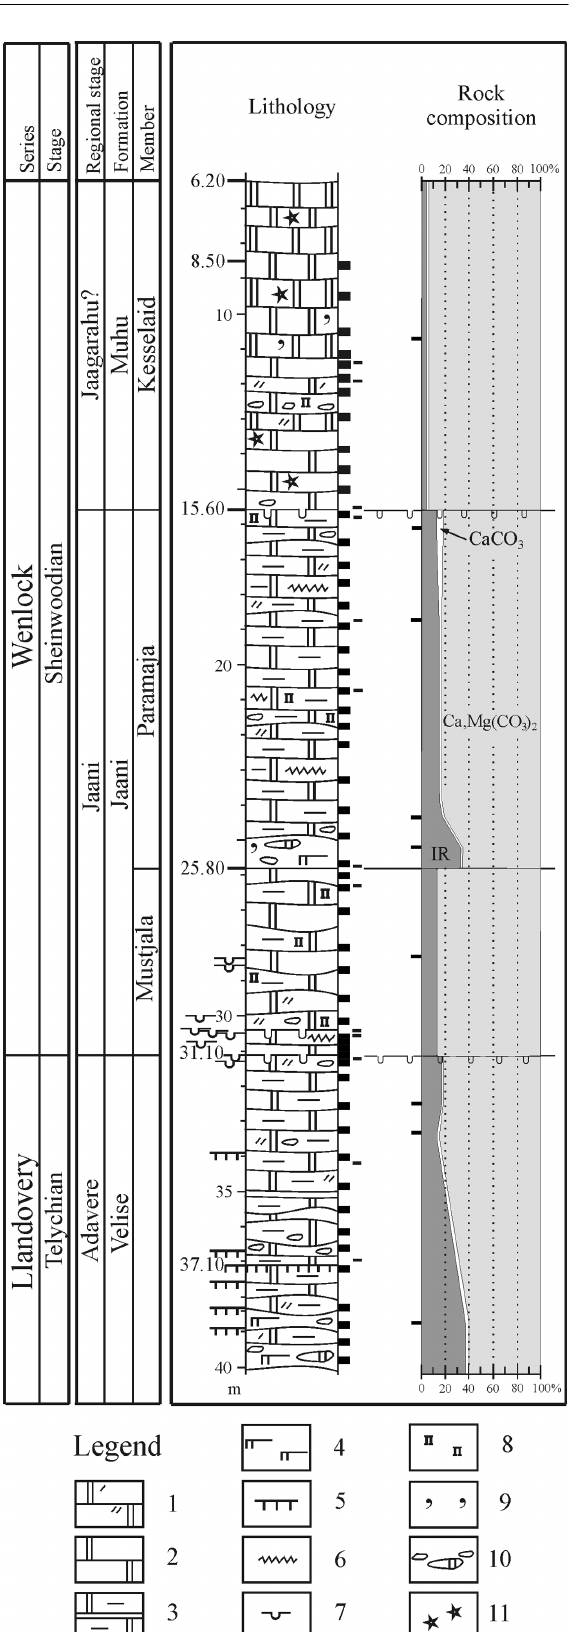
Fig. 2. Suigu (S-3) core section. From left to right: general stratigraphy, regional stratigraphy, lithological log of the section, location of micropalaeontological samples, location of thin sections, rock composition (positions of samples analysed are indicated on the left side). Legend: 1, dolostone (crystal size more than 0.01 mm) with fine and coarse bioclasts; 2, dolostone with crystal size less than 0.01 mm; 3, argillaceous dolostone with interbeds of dolomitic marlstone; 4, dolomitic marlstone; 5, K-bentonite; 6, bioturbation; 7, discontinuity surface; 8, pyritic mottles; 9, glauconite grains; 10, carbonate clasts; 11, vugs. IR, insoluble